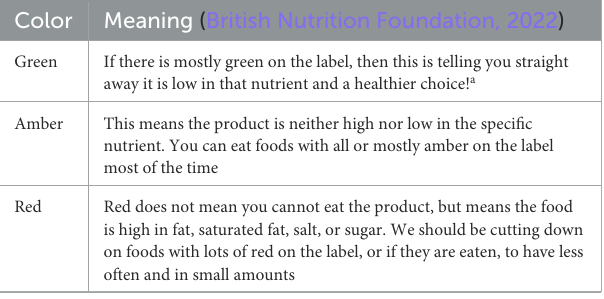
TABLE 1 Meaning of traffic light colors scheme colors, according to the British Nutrition Foundation (2022).